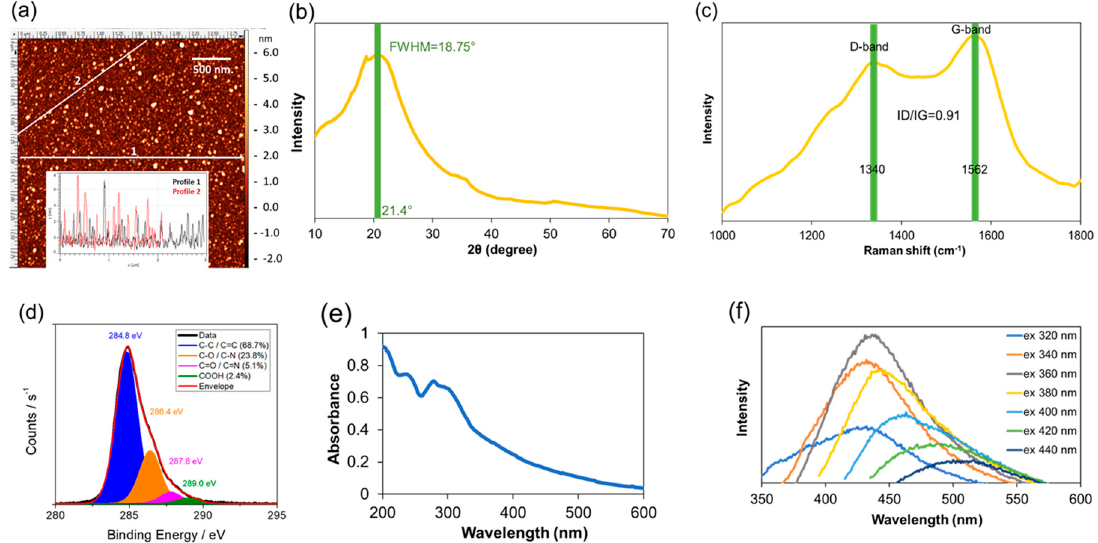
Figure 1. Characterization of unmodified CNDs. ( a ) AFM imaging with representative z-axis profile (inserted); ( b ) XRD spectrum; ( c ) Raman spectrum; and ( d ) XPS spectra of the CNDs; ( e ) UV − vis absorption spectrum; ( f ) Fluorescence emission spectra of the CNDs in deionized water obtained at different excitation wavelengths with a 20 nm increment from 320 to 440 nm.